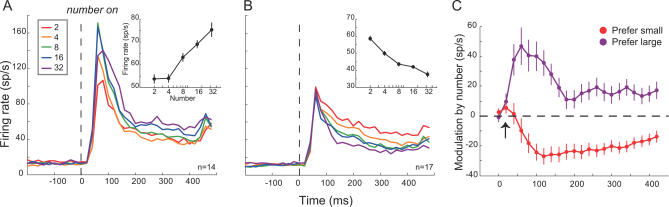
Numerical Selectivity Evolves Rapidly in LIP(A) For 14 neurons preferring large numerosity, averages were calculated in 20-ms bins for trials grouped by stimulus numerosity. Responses are aligned to stimulus onset (dashed vertical line at zero) and shown for the full stimulus period (400 ms). Numerosity is indicated by line color. Inset: average response (mean ± SE) during the epoch 50–450 ms following stimulus onset.(B) Average response of 17 neurons preferring small numerosity. Same conventions as (A).(C) Modulation of response for the two groups of neurons shown in (A) and (B). Linear regression was used to estimate the change in firing rate over the range of numerosities presented in a 40-ms window centered at the time point, sampled every 20 ms. Positive modulation indicates responses that increase with number; negative modulation indicates responses that decrease with increasing number. Arrow: time at which modulation first significantly differs from zero; subsequent time points are also significantly modulated by number (p < 0.05).